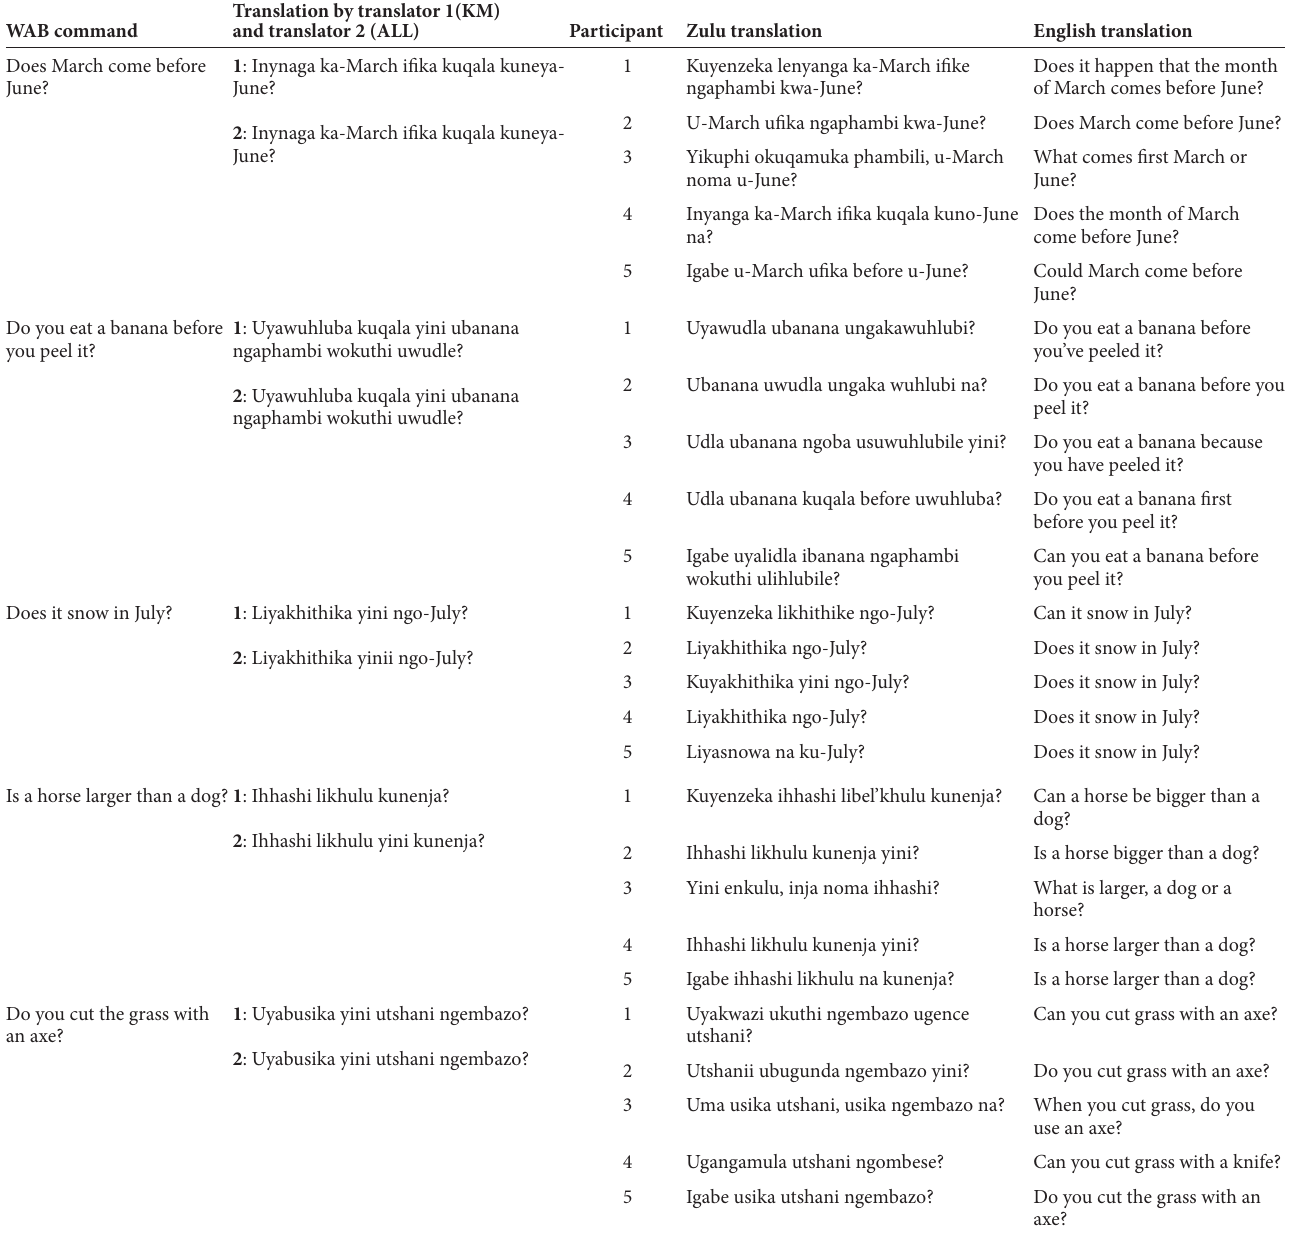
Table 2. Translation of the auditory verbal comprehension subtest of the WAB (continued) WAB